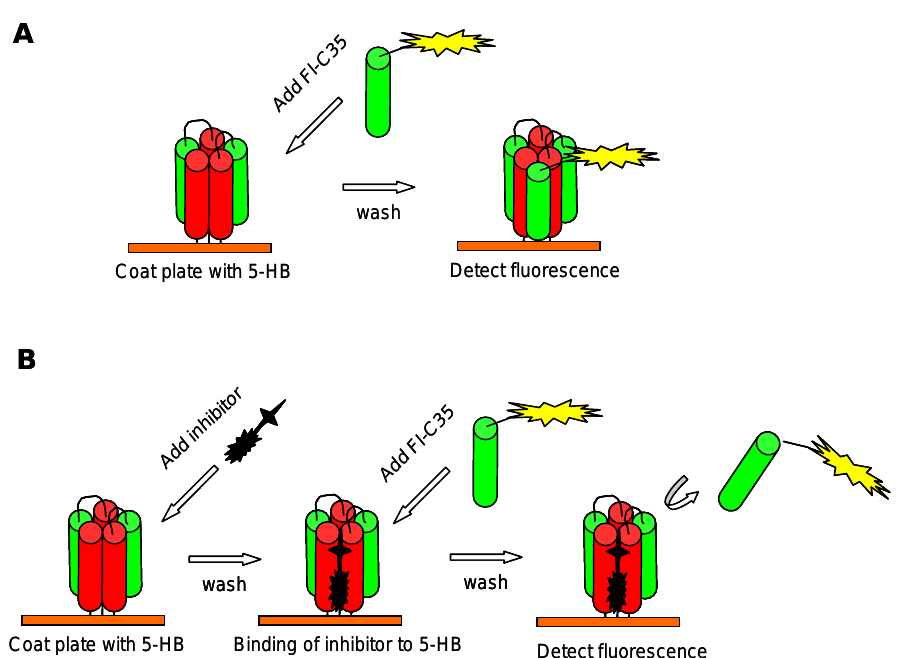
Figure 2. High-throughput (HTS) assays for screening of RSV fusion inhibitors targeting HRA trimer of F protein. ( A ) 6-HB formation by binding FITC-labeled C35 (Fl-C35), as a tracer, to 5-HB that was coated on the well of the culture plate. ( B ) Inhibition of a test compound by competing with Fl-C35 in binding with 5-HB and blocking the 6-HB